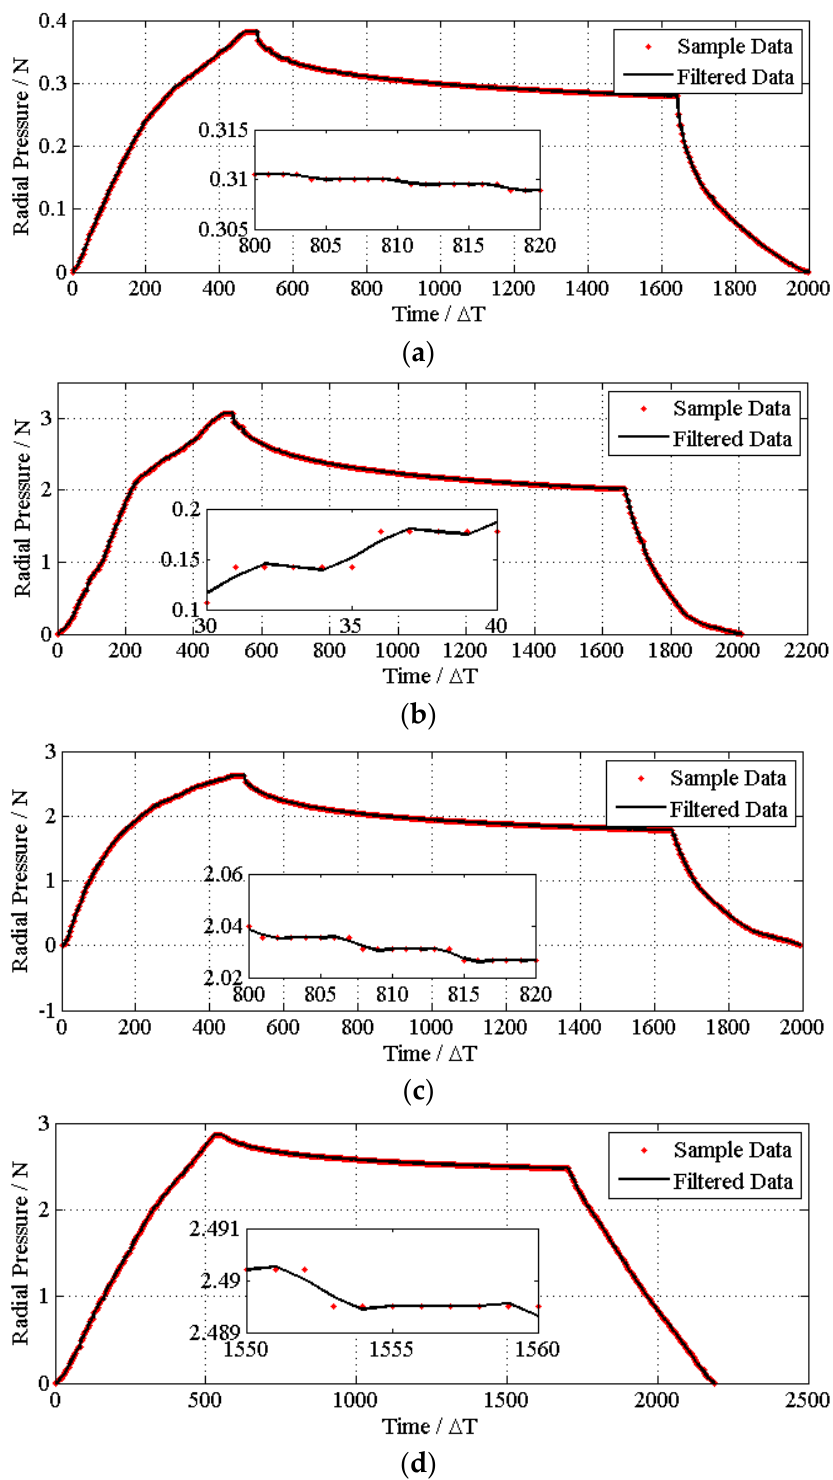
Figure 5. Data filter for each test. The samples data and filtered curves of the tensile strength are shown for PGA ( a ), PGLA ( b ), PGA/PGLA (50/50) ( c ) and commercial PU ( d ), respectively.